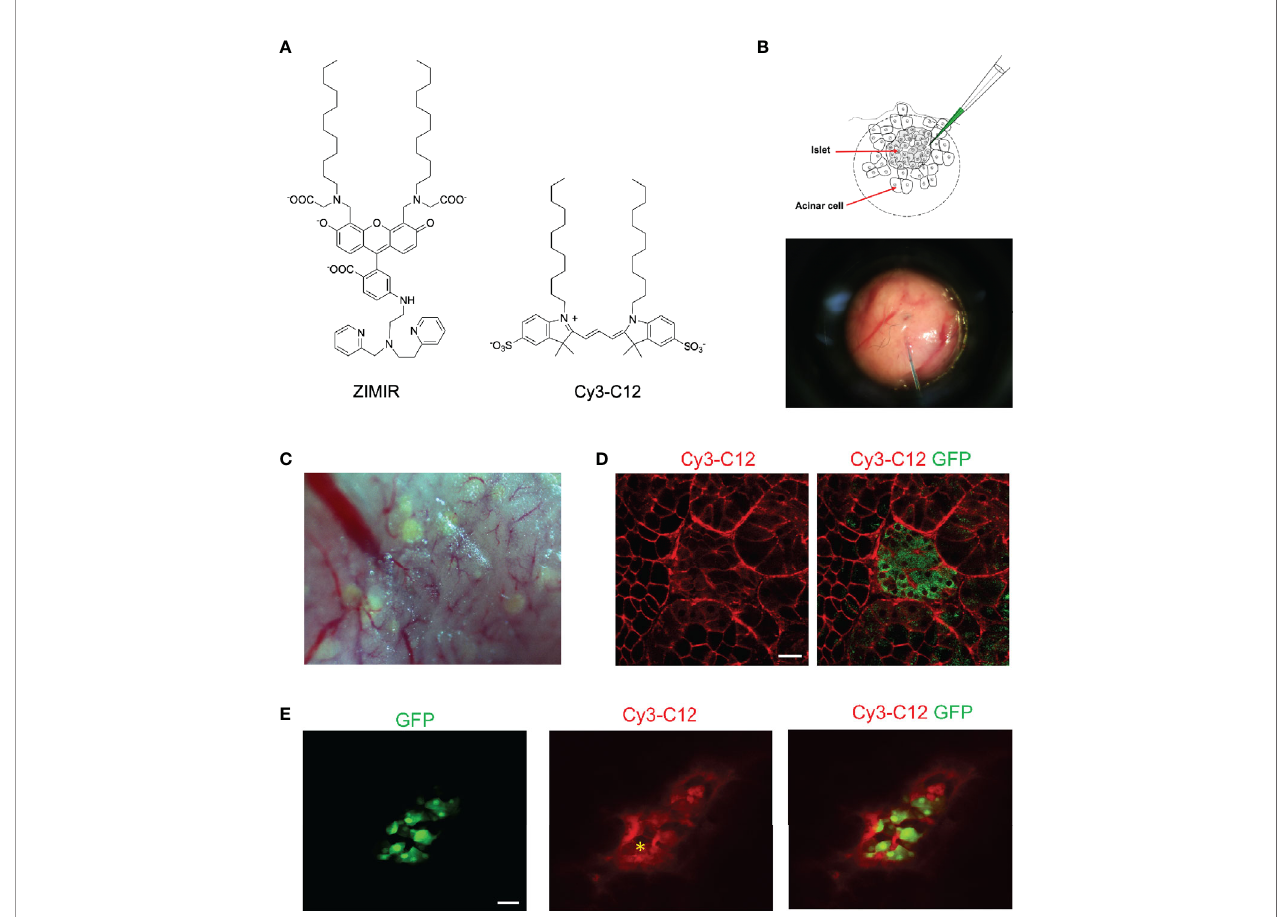
FIGURE 2 | Labeling mouse islet cells in the intact pancreas via microinjection of dye solutions. (A) Chemical structures of ZIMIR and Cy3-C12. (B) Schematic of bolus loading of pancreatic cells via microinjection. The picture showed a needle fi lled with a dye solution piercing into the exocrine tissue near an islet. (C) A bright fi eld image of the pancreatic tissue of a MIP-GFP mouse. Islets near the surface presented as light green puncta arising from GFP expression. (D) Confocal fl uorescence images of a pancreas (MIP-GFP) post-injecting Cy3-C12 into the exocrine tissue. (E) Confocal fl uorescence images of a pancreas (MIP-GFP) where an islet was injected with Cy3-C12. The yellow asterisk indicates the site of injection. Scale bar = 20